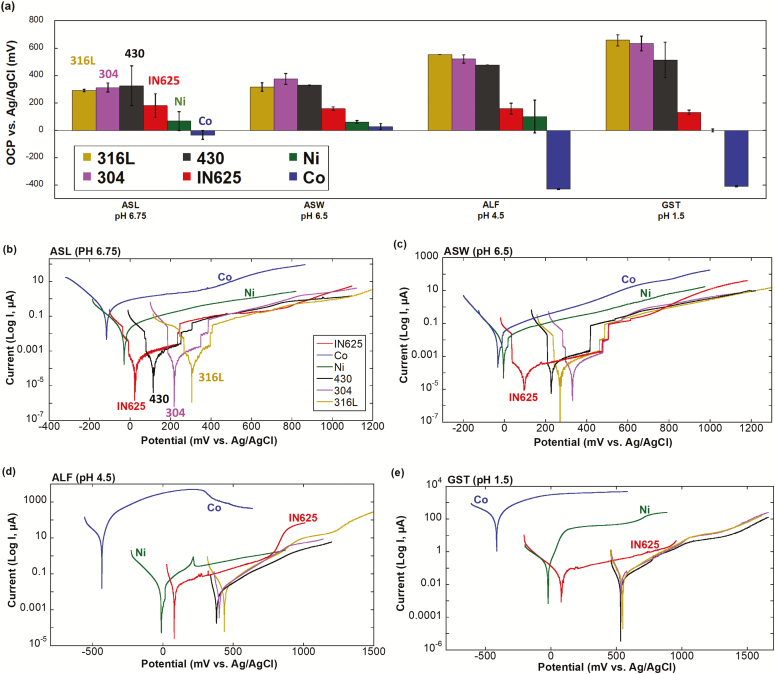
(a) Mean OCP values during 1 h for the alloy (316L, 304, 430, and IN625) and metal powders (Ni and Co) exposed in different synthetic biological fluids. The error bars represent the standard deviation between duplicate independent measurements. (b–e) Representative polarization curves of the investigated powders in each fluid after 1 h stabilization at OCP. Note: Different axis scales.